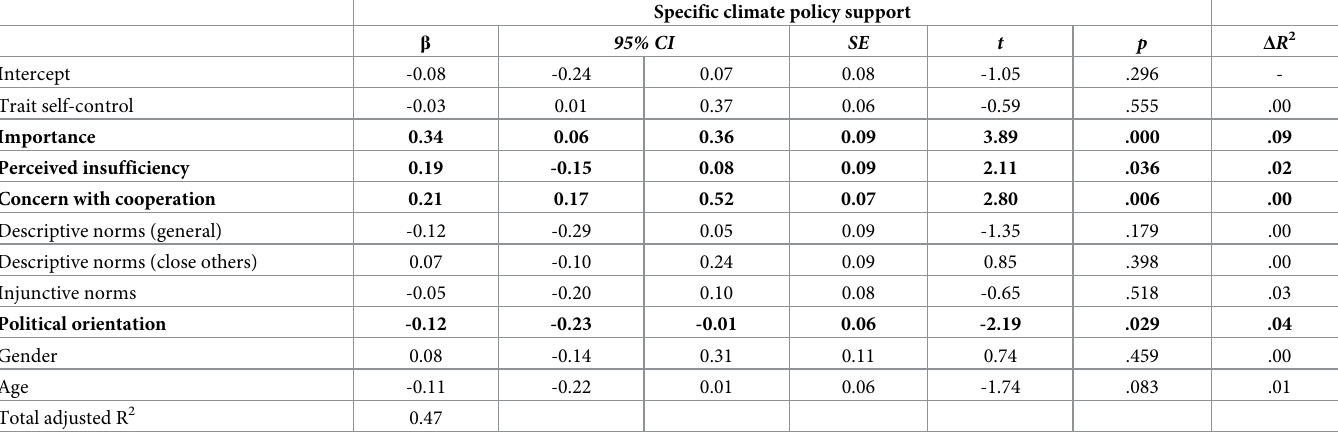
Table 5. Results of a multiple linear regression model predicting support for specific climate